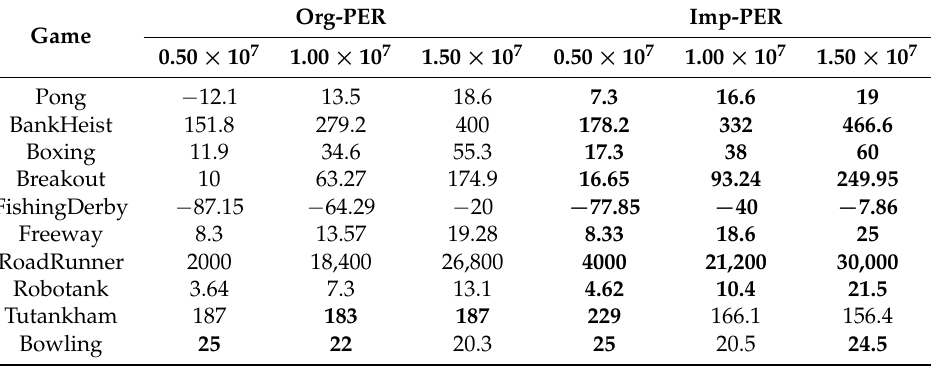
Table 5. The scores achieved by Org-PER and Imp-PER. Each value is estimated by 5 random seeds. The results shows the average scores at 0.50 × 10 7 , 1.00 × 10 7 , and 1.50 × 10 7 training steps respectively. Bold font shows the best